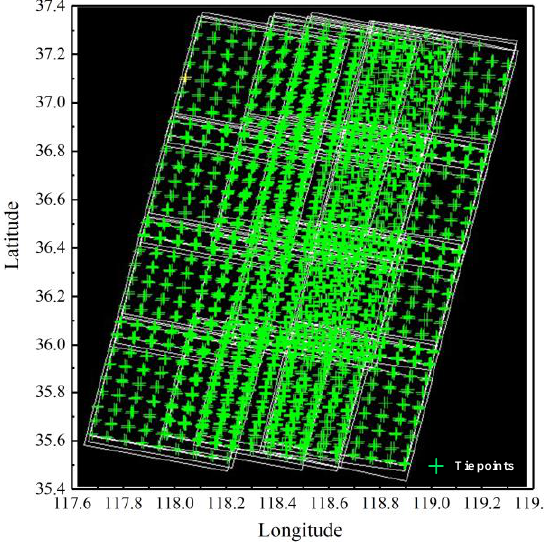
Figure 2. Distribution of images and identified tie points. Based on the identified TPs and generated VCPs, the BA of the multispectral images and stereo TLC images were achieved together under the condition without use of GCPs. All the BA calculations were achieved on a personal computer in one minute.